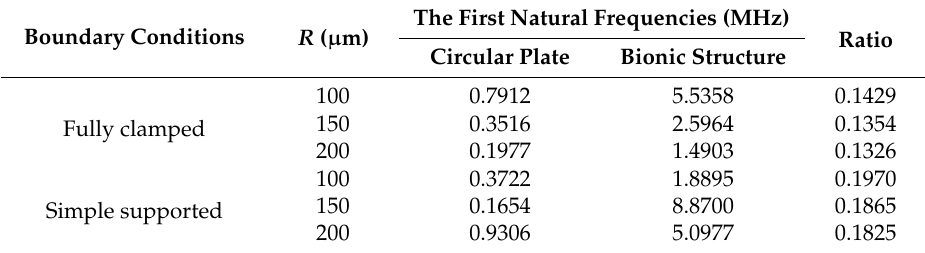
Table 8. Comparison of the first natural frequencies between the circular plate and the bionic